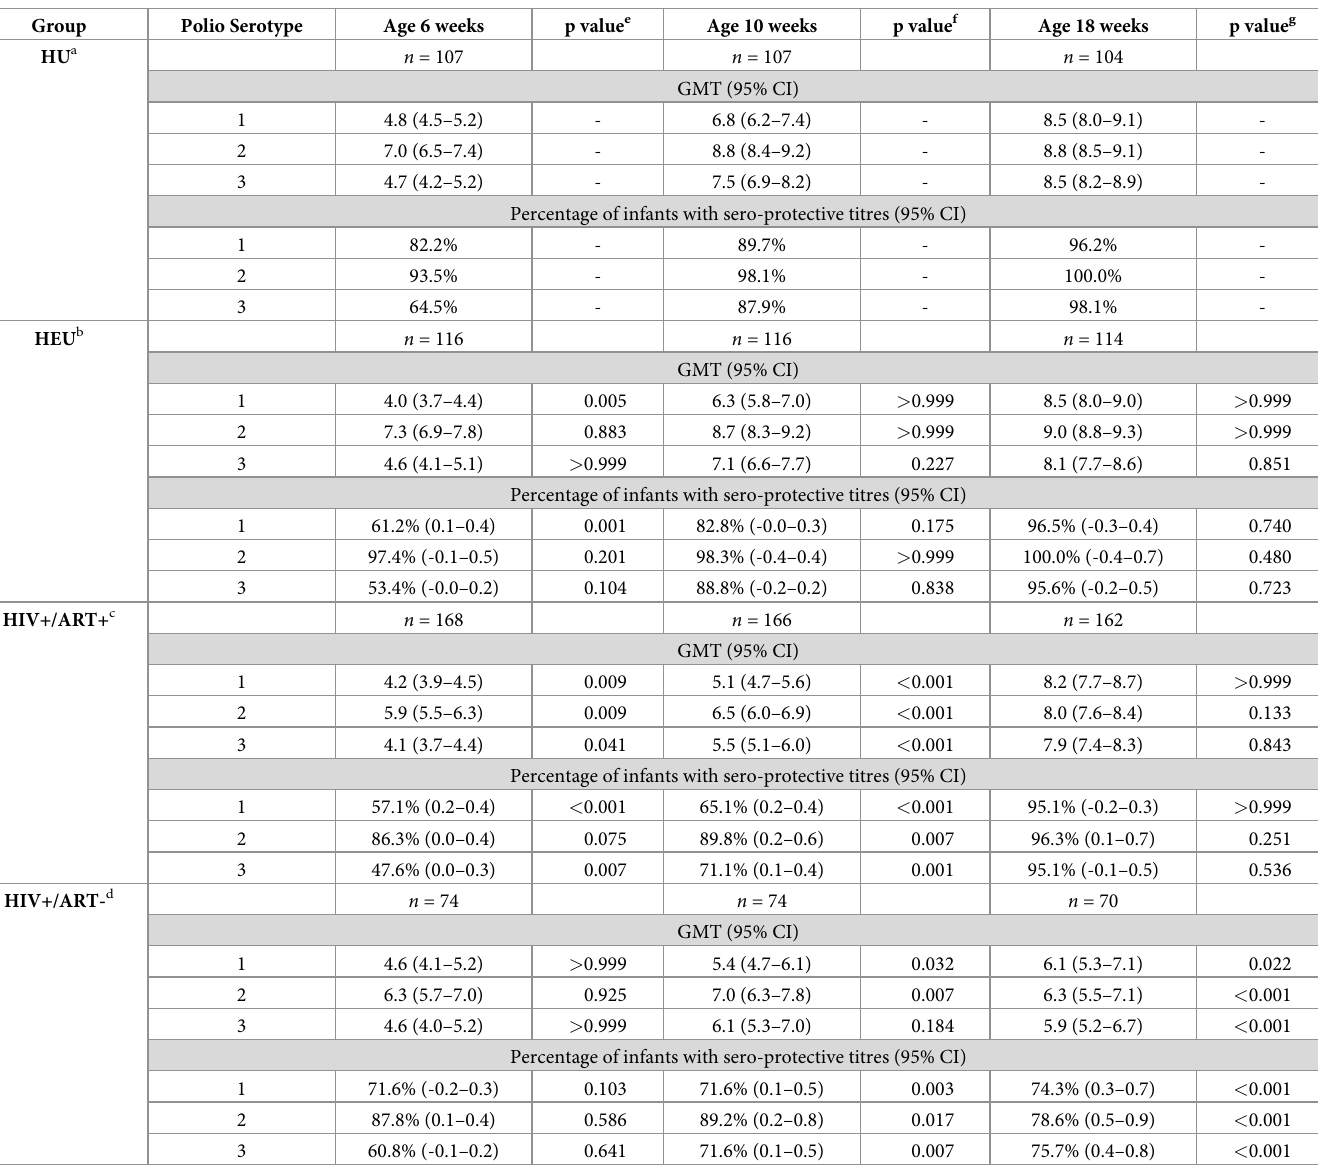
Table 2. Geometric mean titres and percentage of infants with sero-protective titres at 6, 10 and 18 weeks of age.